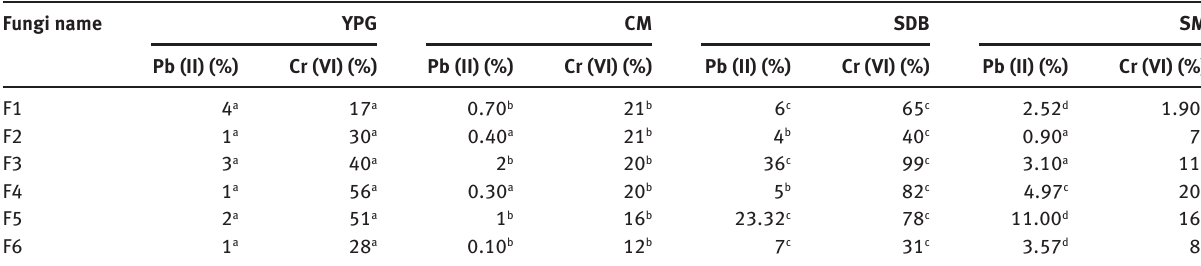
Table 1: Removal efficiency of heavy metals in the one-step process. Fungi